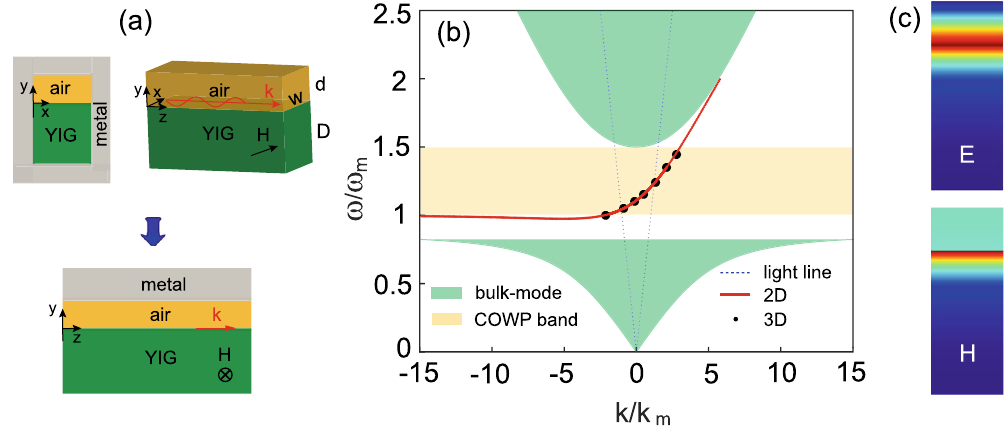
Figure 1. ( a ) Upper left panel, the crossection of the 3D one-way waveguide; upper right panel, the internal structure of the 3D waveguide; lower panel, the 2D system physically equivalent to the 3D waveguide. ( b ) Dispersion relations for the 2D (solid line) and 3D (solid circles) guiding systems. The uppermost and lowest shaded areas represent the zones of bulk modes in the YIG, and the middle rectangular one represents the COWP region for the 2D and 3D systems. ( c ) Modal fields at 5.6 GHz. The parameters of the systems are as follows: ε m = 15, ω 0 = 0.5 ω m , and ν = 0; d = 3 mm, w = 5 mm, and D = 9